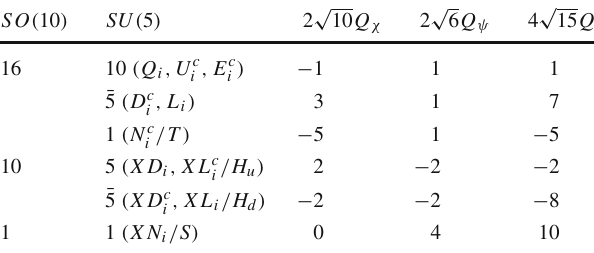
Table1 Decompositionofthe E 6 fundamental 27 representationunder SO ( 10 ) , SU ( 5 ) , and the U ( 1 ) χ , U ( 1 ) ψ and U ( 1 ) (cid:3) charges SO ( 10